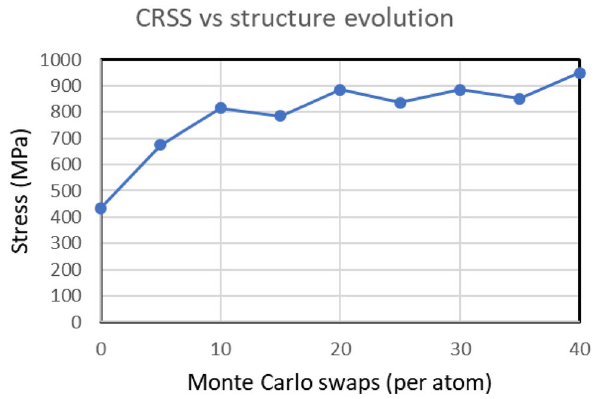
Figure 4. Variation of critically resolved shear stress for TaNbHfZr R-HEA w.r.t. Monte Carlo structure